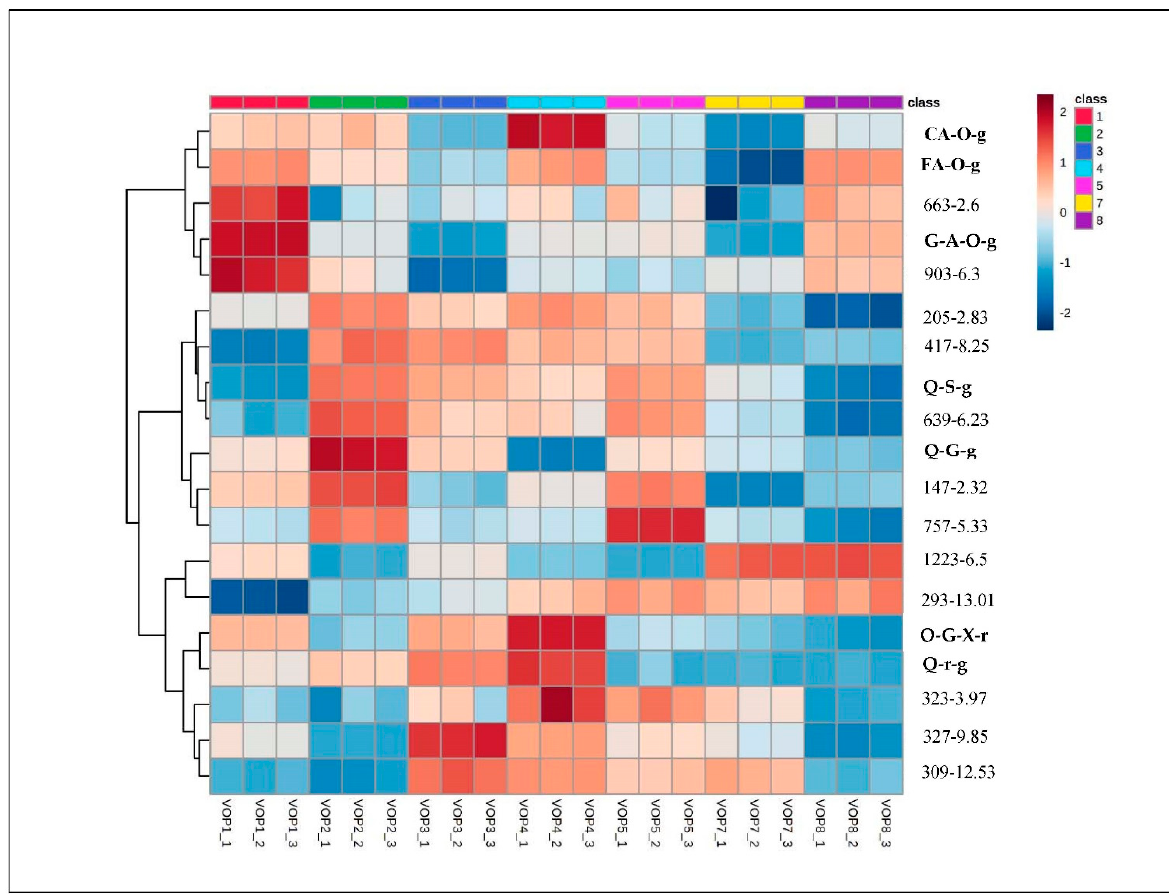
Figure 4. Heat map of nineteen phenolic metabolites (variables) in hierarchical clustering in the leaves of cowpea cultivars. Gentisic acid 5- O -glucoside (G-A- O -g); p-Coumaric acid O -glucoside (CA- O -g); Ferulic acid O -glucoside (FA- O -g); Quercetin 3-sambubioside-3 ′ -glucoside (Q-S-g); Quercetin 3-glucosyl-(1->2)-galactoside (Q-G-g); Quercetin 3-(2G-xylosylrutinoside) (Q-G-X-r); Quercetin 3- O -rhamnoside 7- O -glucoside (Q-r-g). The pattern and magnitude relating to the colour intensity (hue) from +2 to − 2 and 0 as symmetry) relating to visualization of response intensities of 19 compounds (identified and unidentified compounds) present in theses cowpea cultivars.